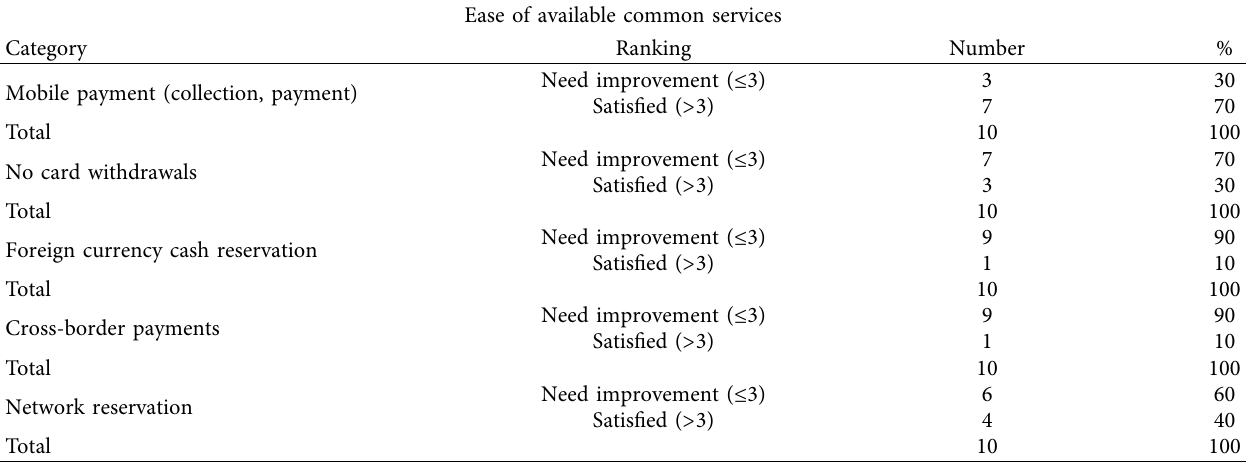
Table 9: Summary of the available convenience